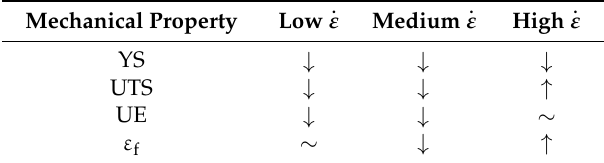
Figure 3. ( a ) Engineering stress-strain and ( b ) true stress-true strain curves of the X6MnAl12-3 alloy tested at different strain rates. ( c ) Overview of the strain-rate-dependent mechanical properties. Table 2. Impact of an increase in strain rate for low, medium, and high strain rates (cf. Figure 3).